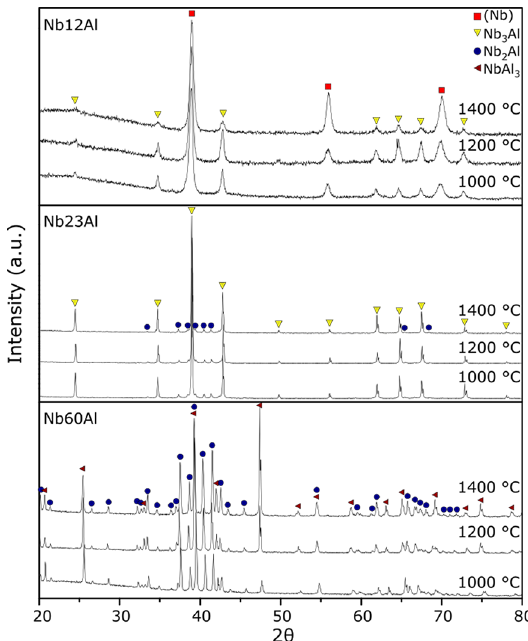
Figure 1. X-ray diffractograms of the Alloys: [a] Nb12Al, [b] Nb23Al and [c] Nb60Al equilibrated at 1000, 1200 and 1400 °C.